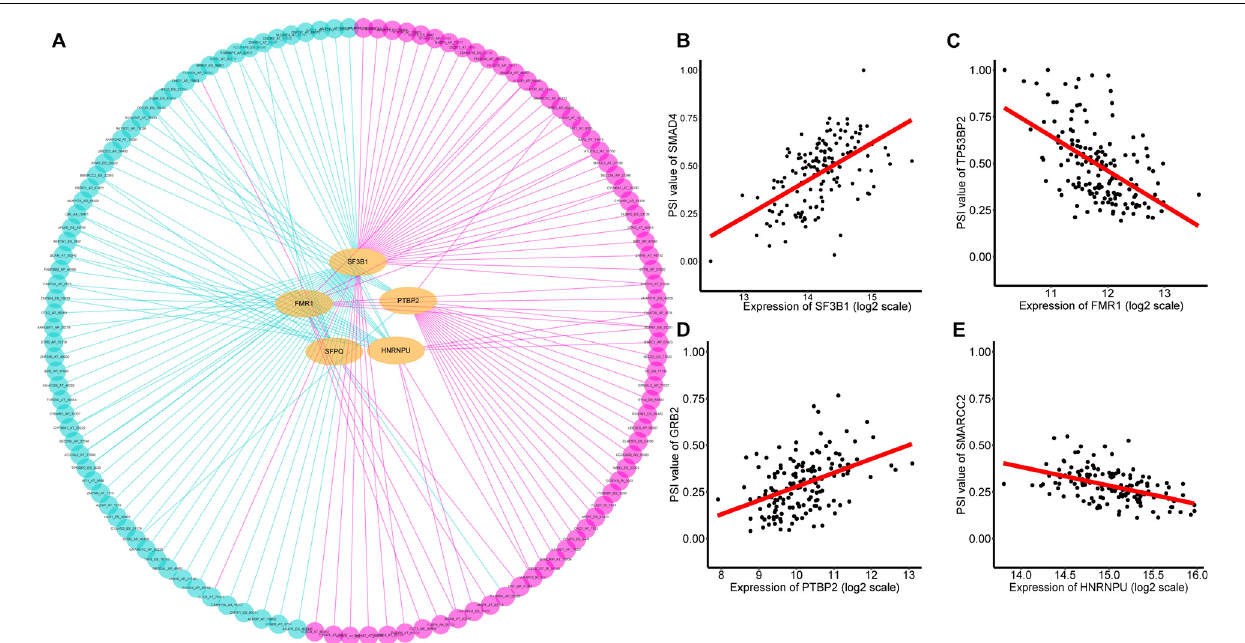
FIGURE 8 | Prognosis related SFs and the splicing regulatory network of TNBC. (A) Splicing regulatory network of TNBC was constructed built by Cytoscape software. Splice factors (orange dots) were positively (pink edges) or negatively (green edges) associated with AS events, which predicted favorable (pink dots, HR < 1) or adverse (green dots, HR > 1) outcomes in patients with TNBC. (B–E) A correlation between the expression of AS factor and the PSI value of prognosis-associated splicing